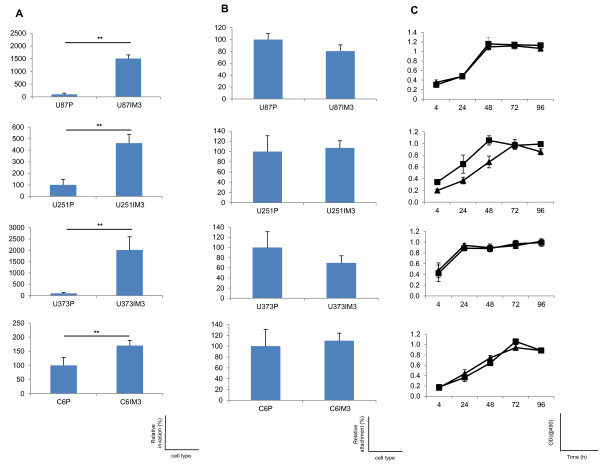
Invasion, attachment, and proliferation assay of glioblastoma cells. All assays were performed with four different glioblastoma cell lines: U87, U251, U373, and C6 (Top to bottom). Values in (A) and (B) are expressed as a percentage of corresponding parental line data. (A) Invasion: IM-3 subpopulations were compared to their parental lines. (B) Attachment: Cells adherent to Matrigel® after 4 h were stained with hematoxylin QS and counted. (C) Proliferation: The rate of cell proliferation was evaluated with CellTiter 96 Aqueous One Solution (Promega) at five different time points, 4 h, 24 h, 48 h, 72 h and 96 h after seeding cells. Triangles - IM-3 lines, squares - parental. Data are represented as means ± SD (n = 3). P, parental cells; IM3, IM3 cells; IM3, IM3 cell line; **, p < 0.01.